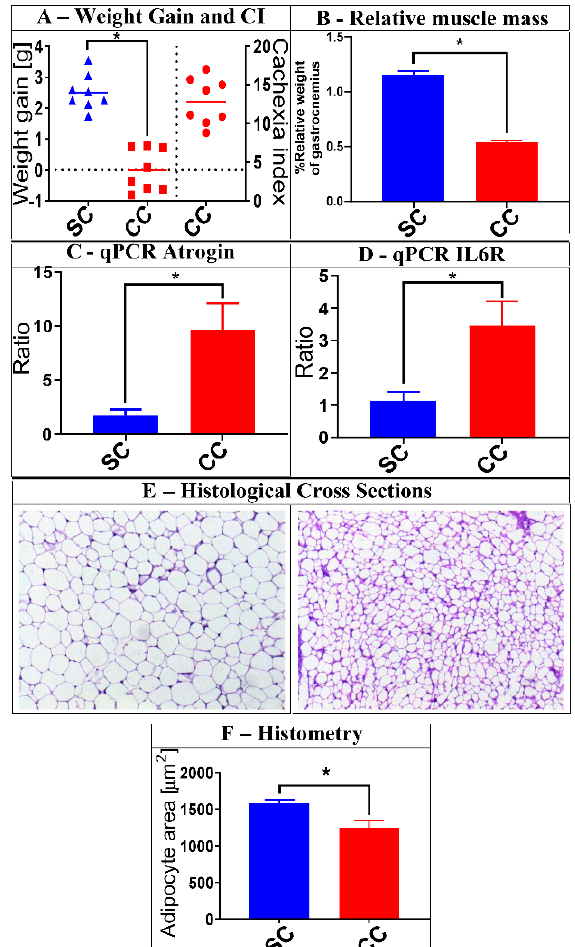
Figure 1. Characterization of cachexia in the animals selected for this study. A group of 16 animals was selected for the analyses described herein. Eight (8) of them received saline injection (SC group), while the other 8 were injected with Lewis lung carcinoma (LLC) cells (CC group). After 28 days, the animals were evaluated for a series of characteristics typically associated with cachexia. Panel ( A ) shows, on the left part of the graph, the average weight gain of the SC and CC animals 28 days after injection (tumor weight subtracted), as well as the Cachexia Indexes (CI) among CC animals (on the right part of the graph) (Weight gain: SC = 2.508 ± 0.1996; CC = − 0.00625 ± 0.2391. Cachexia index: CC = 12.86 ± 1.06). Panel ( B ) shows the reduced relative mass of gastrocnemius muscle in CC animals, when compared to SC controls (SC = 1.151 ± 0.09864; CC = 0.5373 ± 0.04663). Panels ( C , D ) show that CC animals also display increased relative expression of muscular atrophy and inflammation markers (Atrogin and IL6R, respectively), as verified by qPCR (Atrogin: SC = 1.421 ± 0.3972; CC = 9.661 ± 2.471. IL6R: SC = 1.062 ± 0.1726; CC = 3.573 ± 0.707). Panel ( E ) shows examples of histological analyses made with epididymal adipose tissue obtained from SC (left) and CC (right) animals, demonstrating significant reduction in the average adipocyte area in CC animals. These reductions are confirmed by histometric evaluation of representative cross sections obtained from all animals within each group (Panel ( F )) (Adipocyte area: SC = 1573 ± 45.83; CC = 1197 ± 77.71). Magnification of adipose tissue: 20 × ; * = p ≤ 0.05, after Mann–Whitney U test. Results for SC animals are shown in blue, while results for CC animals are shown in red. Plots represent mean and mean standard